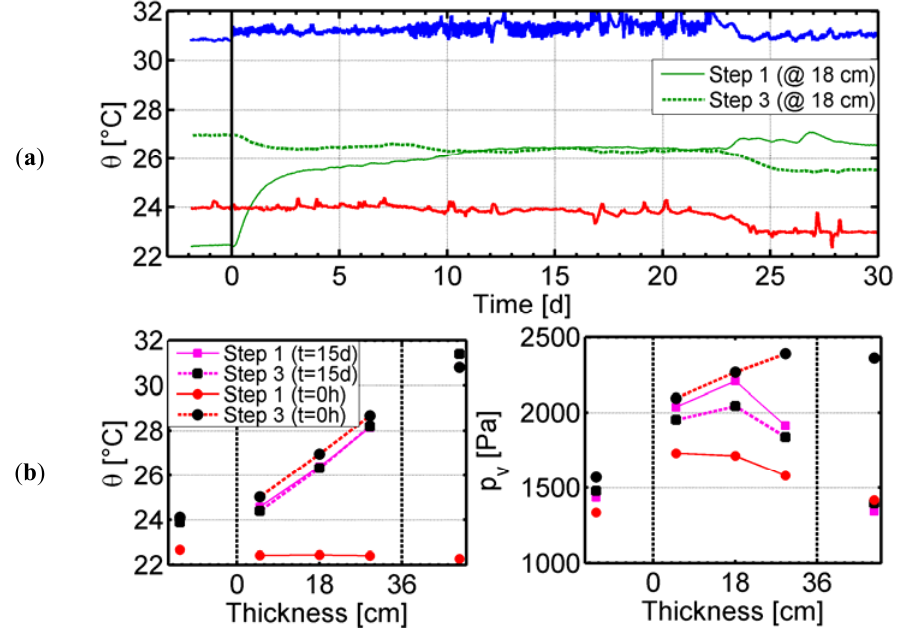
Figure 9. ( a ) Time response in θ at the wall center; ( b ) and spatial response in θ and p uncoated hemp concrete wall subjected to Experiment 1 (solid lines) and Experiment 3 (dashed